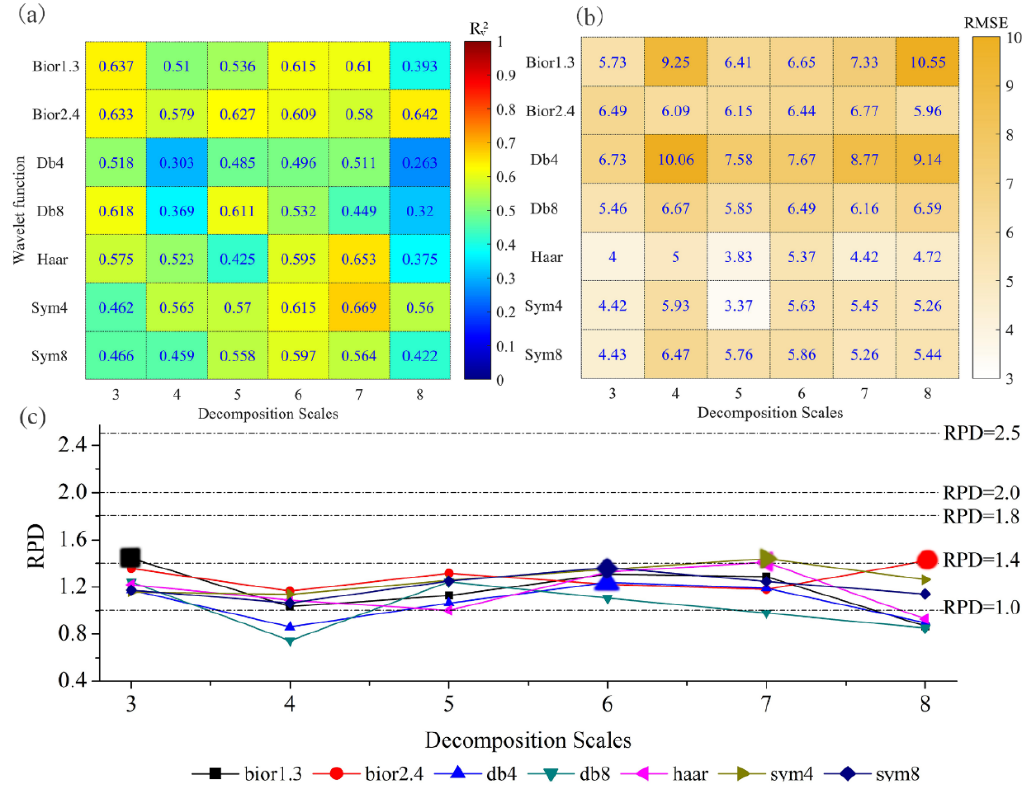
Figure 6. Coefficients of determination ( R v 2 ) ( a ), RMSE ( b ), and RPD ( c ) between the laboratory-measured SOMs and the DWT–PLS predictions on the SOM validation dataset.